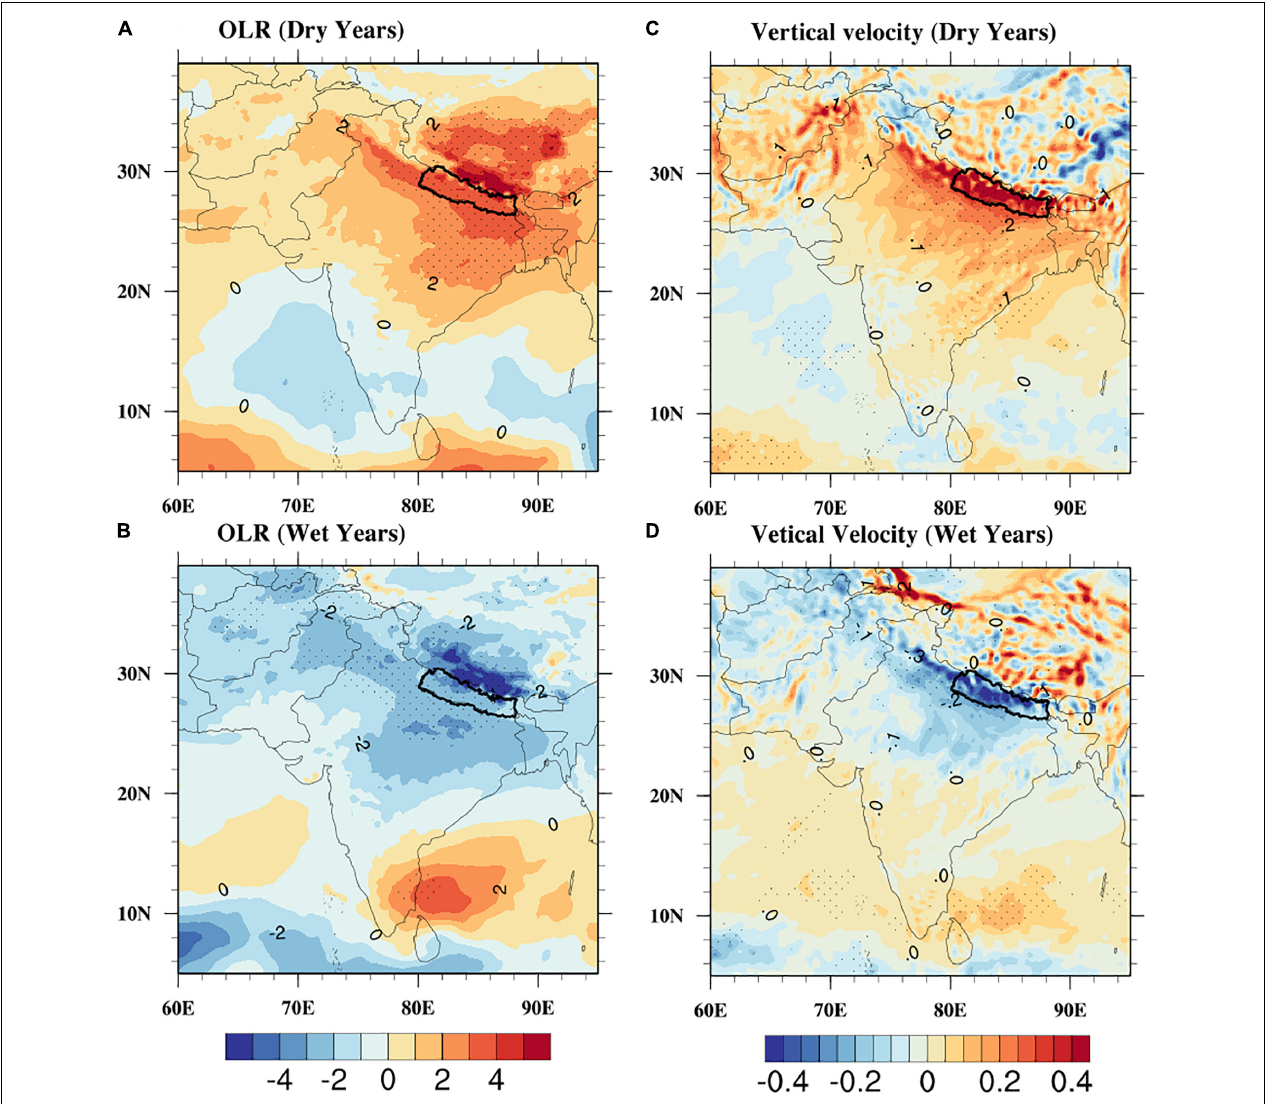
FIGURE 9 | Composite OLR anomalies (10 − 5 , W/m 2 ) for (A) dry years, (B) wet years, and Vertical velocity (10, Pas − 1 ) for (C) dry years, and (D) wet years based on ERA5 reanalysis data during 1987–2015. The dotted points represent the significance at a 95% confidence